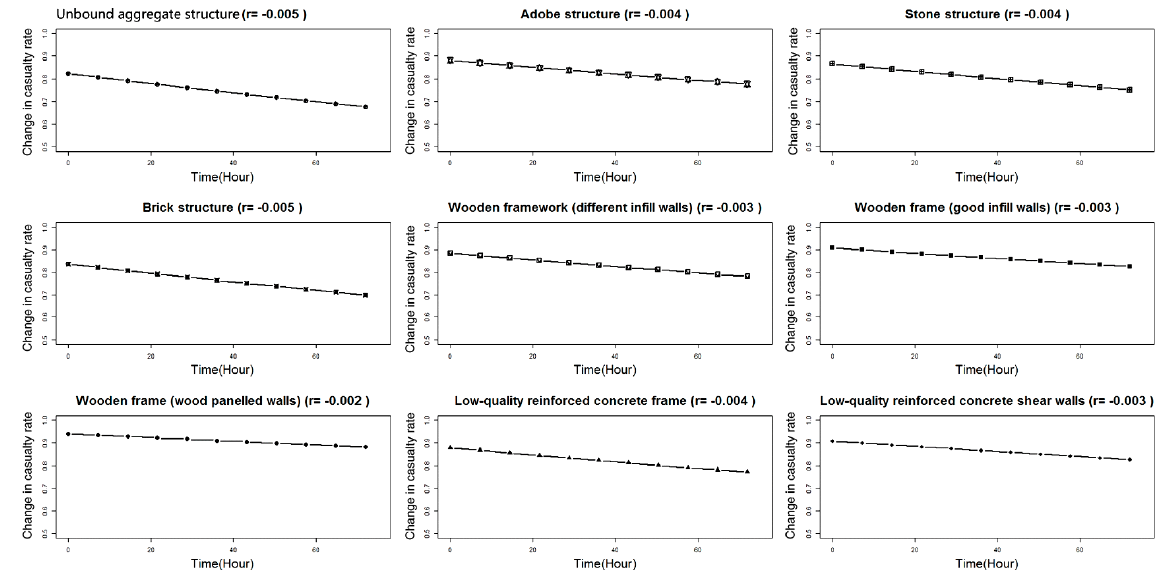
Figure 8. Change in the survival rate of different buildings in a damaged